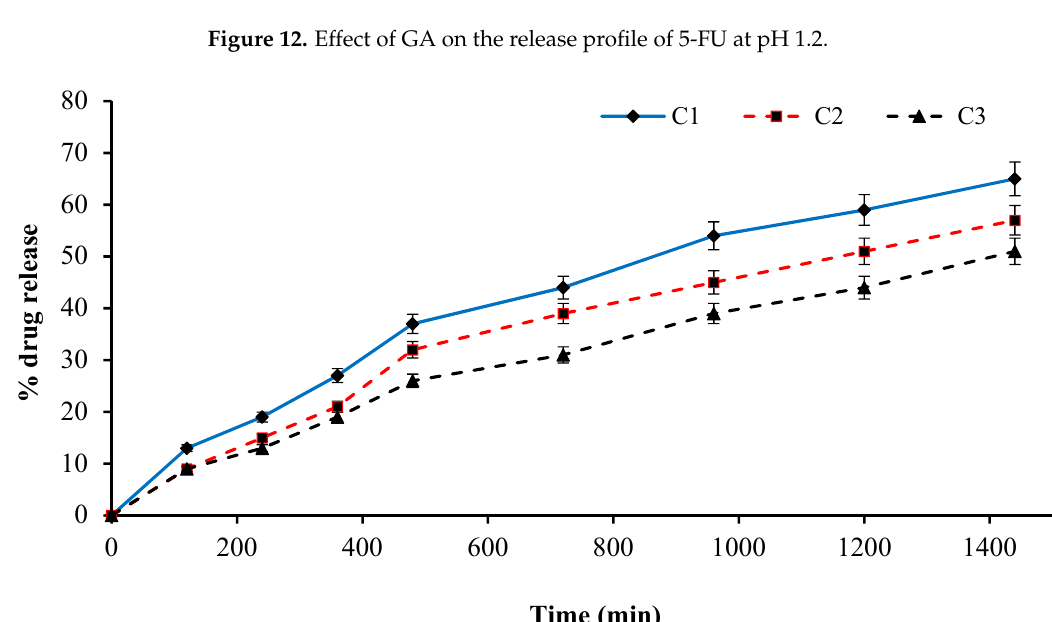
Figure 13. Effect of GA over 5-FUrelease profile at pH 7.4.